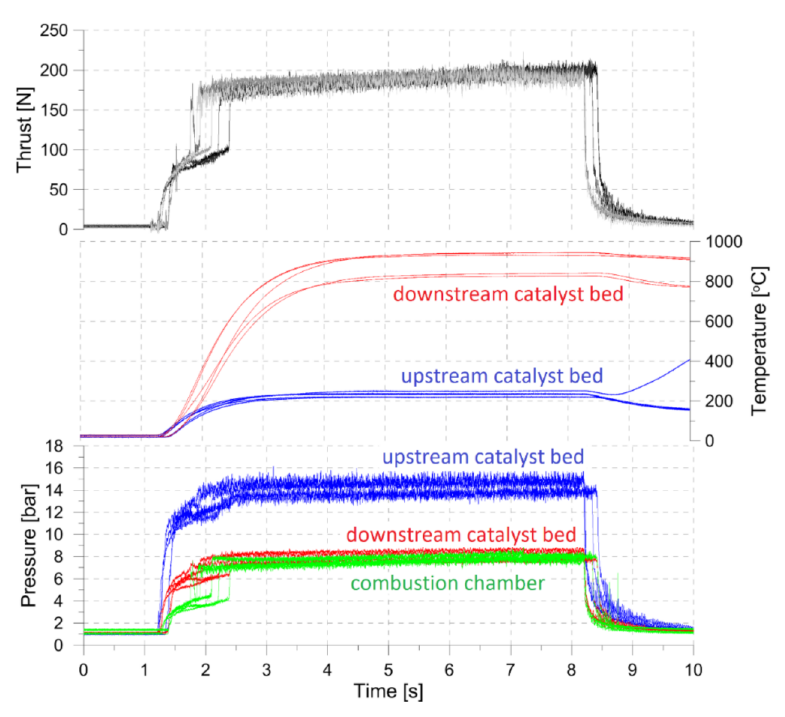
Figure 6. Operating parameters of a subscale hybrid rocket motor (tests of 98% HTP with HDPE)— results of four subsequent hot fire